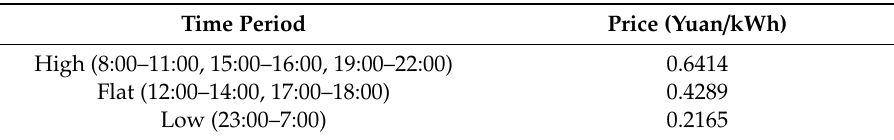
Table 6. TOD tari ff for agricultural